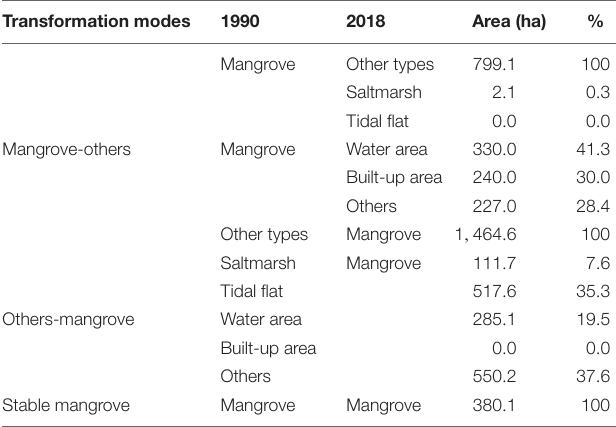
TABLE 3 | Three transformation modes between mangrove and other types between 1990 and 2018. Transformation modes